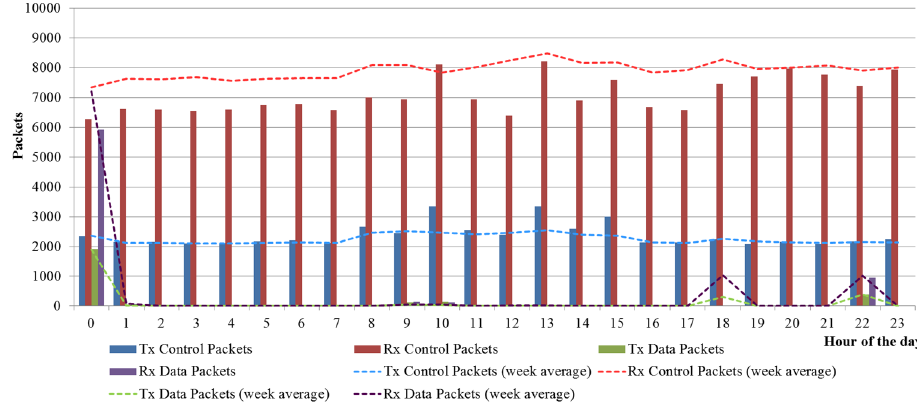
Figure 12. Graphical report of the number of data and control packets in the PLC subnetwork.